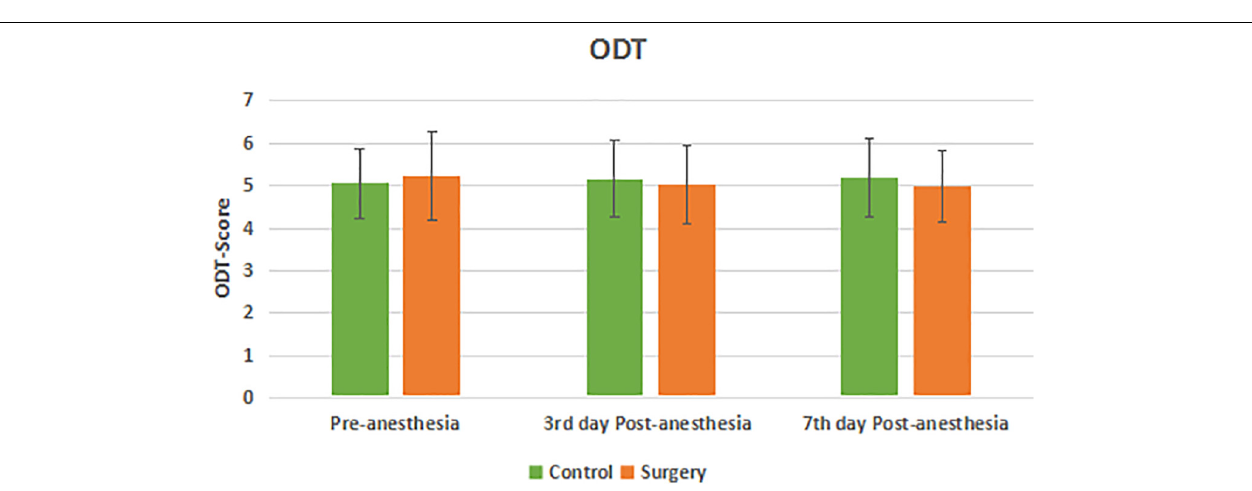
in 7 patients, accounting for 23.33% of the surgical